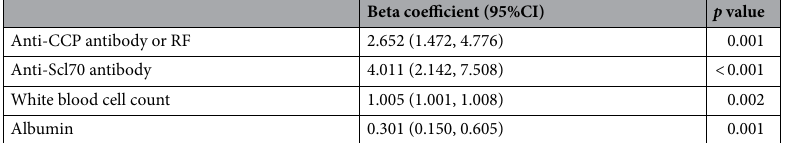
Table 7. Factors associated with ILD in patients with SSc in multivariate linear regression analysis. Bold text indicates statistical significance. ILD, interstitial lung